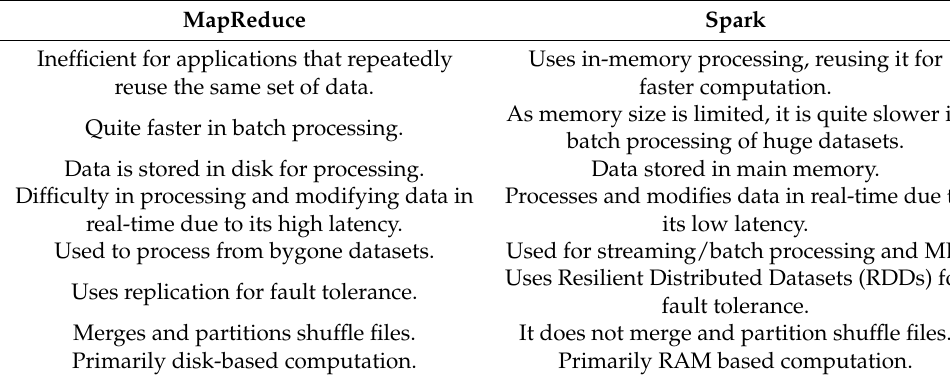
Table 7. MapReduce and Spark